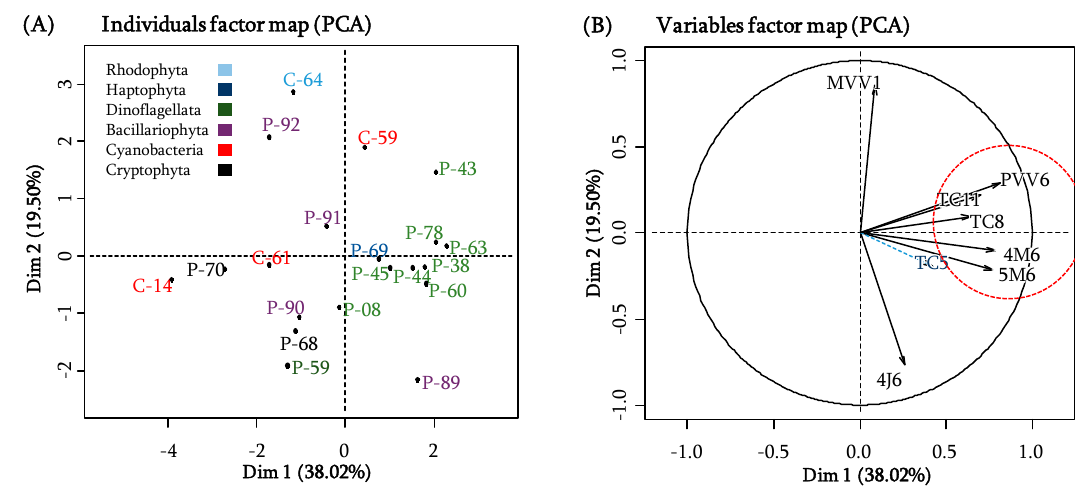
Figure 5. PCA analysis of bacterial adhesion. ( A ) the identification map of microalgae (ID), ( B ) the correlation circle with the bacterial strains that contributes the most to the formation of axis.